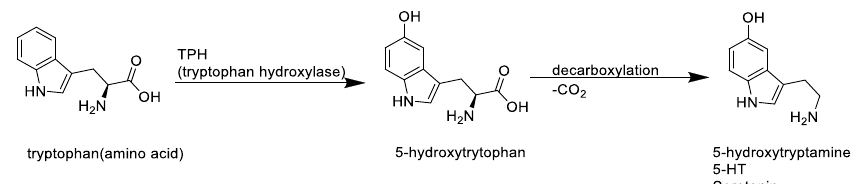
Figure 1. The synthesis of serotonin (5-hydroxytryptamine [5-HT]). Oh et al. [7] reported that serotonin regulates white and brown adipose tissue function. Mice with inducible TPH1 KO in adipose tissues exhibit inhibition of lipogenesis in epididymal white adipose tissue (WAT), induction of browning in inguinal WAT, and activation of adaptive thermogenesis in brown adipose tissue (BAT).